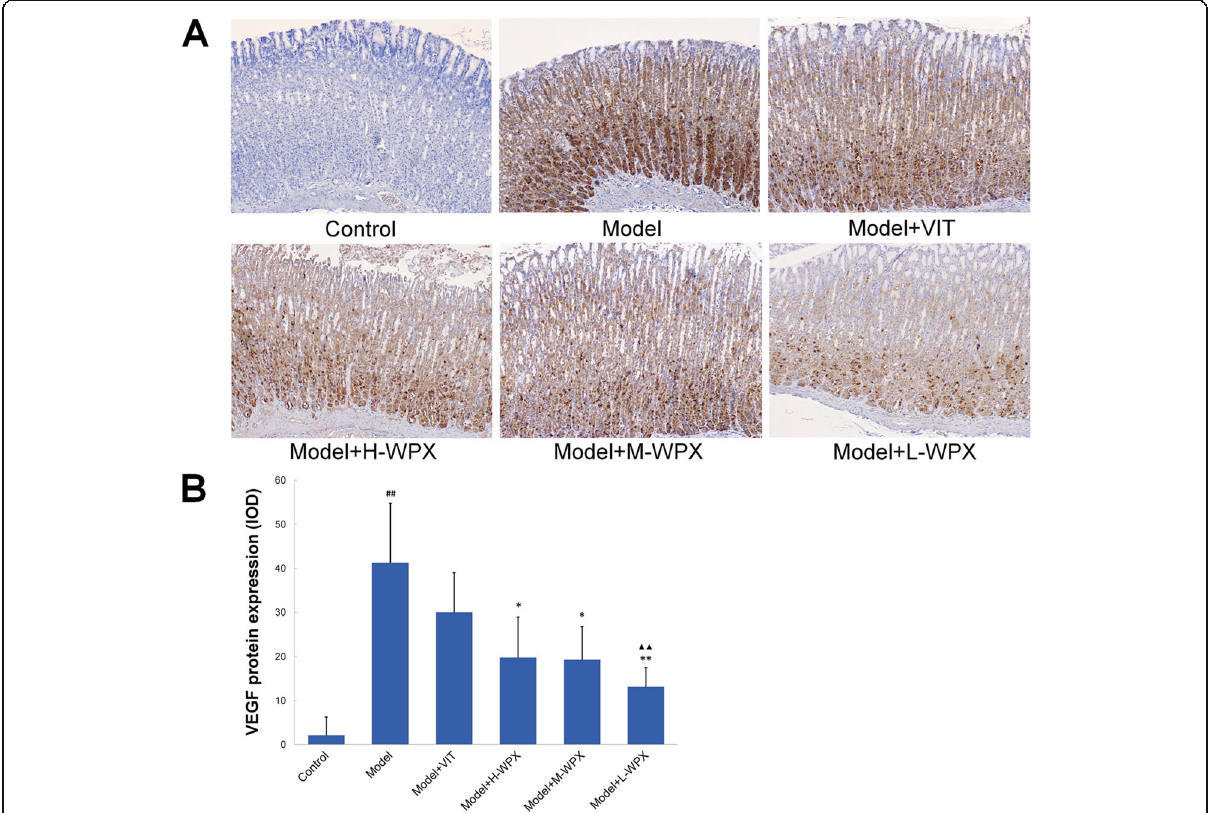
Fig. 8 Effect of WPX on VEGF protein expressions in gastric epithelium. a VEGF protein expressions in gastric epithelium in various groups. b IOD scores of HIF-1 α protein levels. The results are expressed as mean ± SD ( n = 9 in each group). Note: ## P < 0.01, vs Control; ** P < 0.01, * P < 0.05, vs Model; ▲▲ P < 0.01, vs VIT. (IHC,